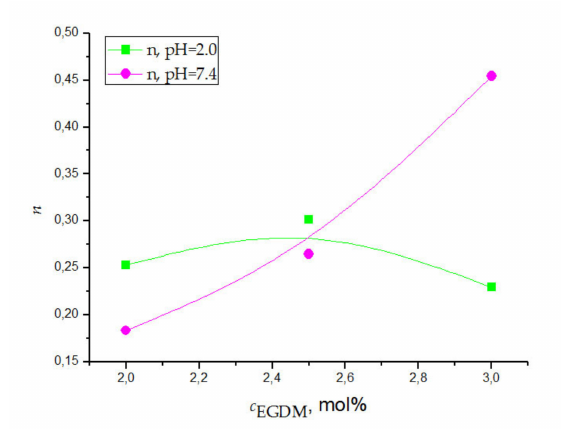
Figure 7. Dependence of n versus EGDM cross-linker content, according to p( N iPMAm) hydrogel swelling in fluid pH = 2.0 and pH = 7.4 at 20 ◦ C.